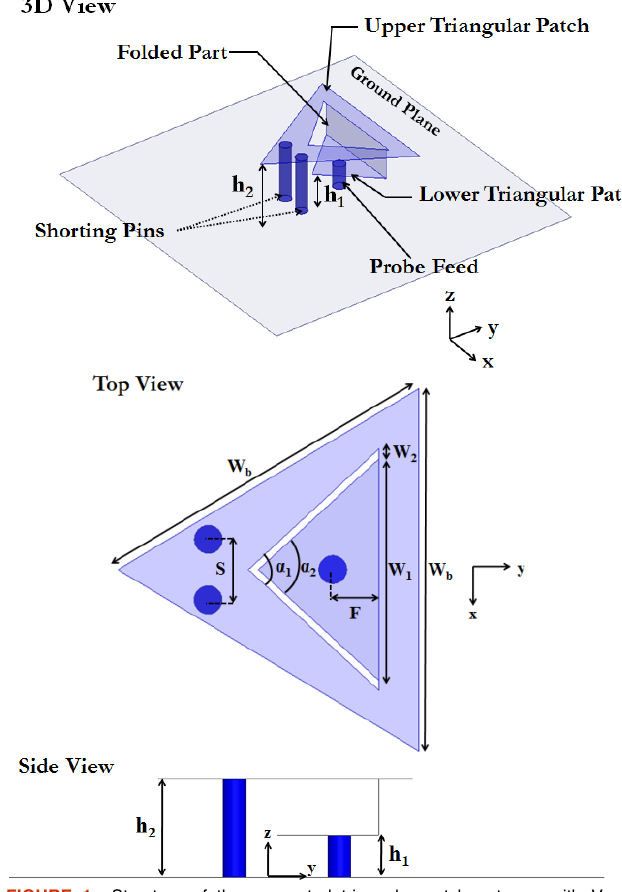
FIGURE 1 . Structure of the suggested triangular patch antenna with V- shaped